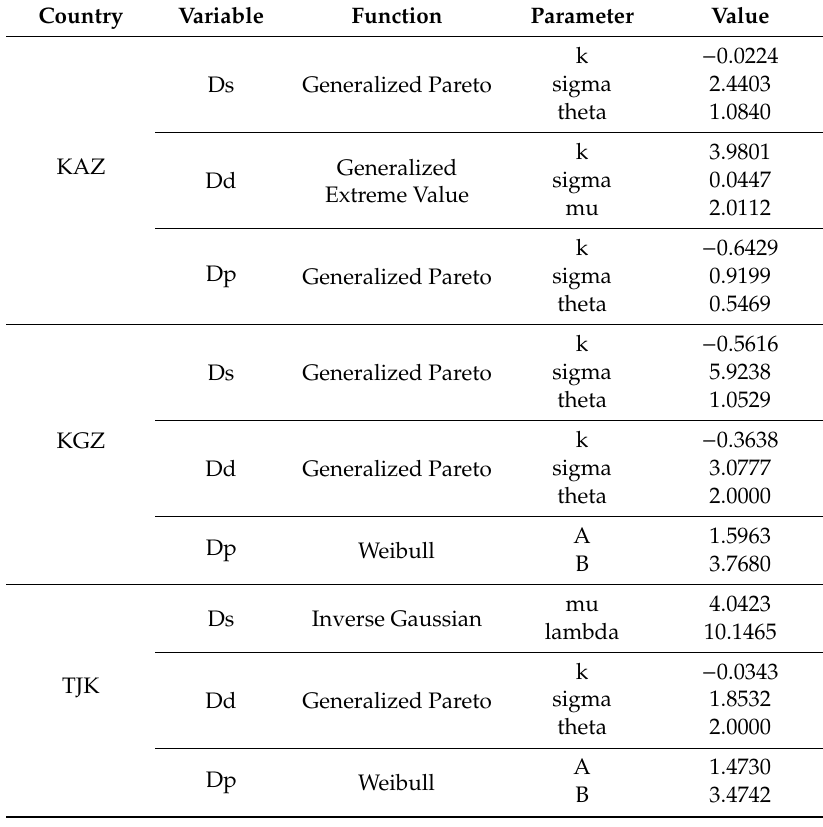
Figure 6. The marginal distribution fitting map and Quantile-Quantile(Q-Q) plot of Tajikistan drought variables from 1961 to 2017. Table 4. Variables corresponding to the parameter of the distribution function.